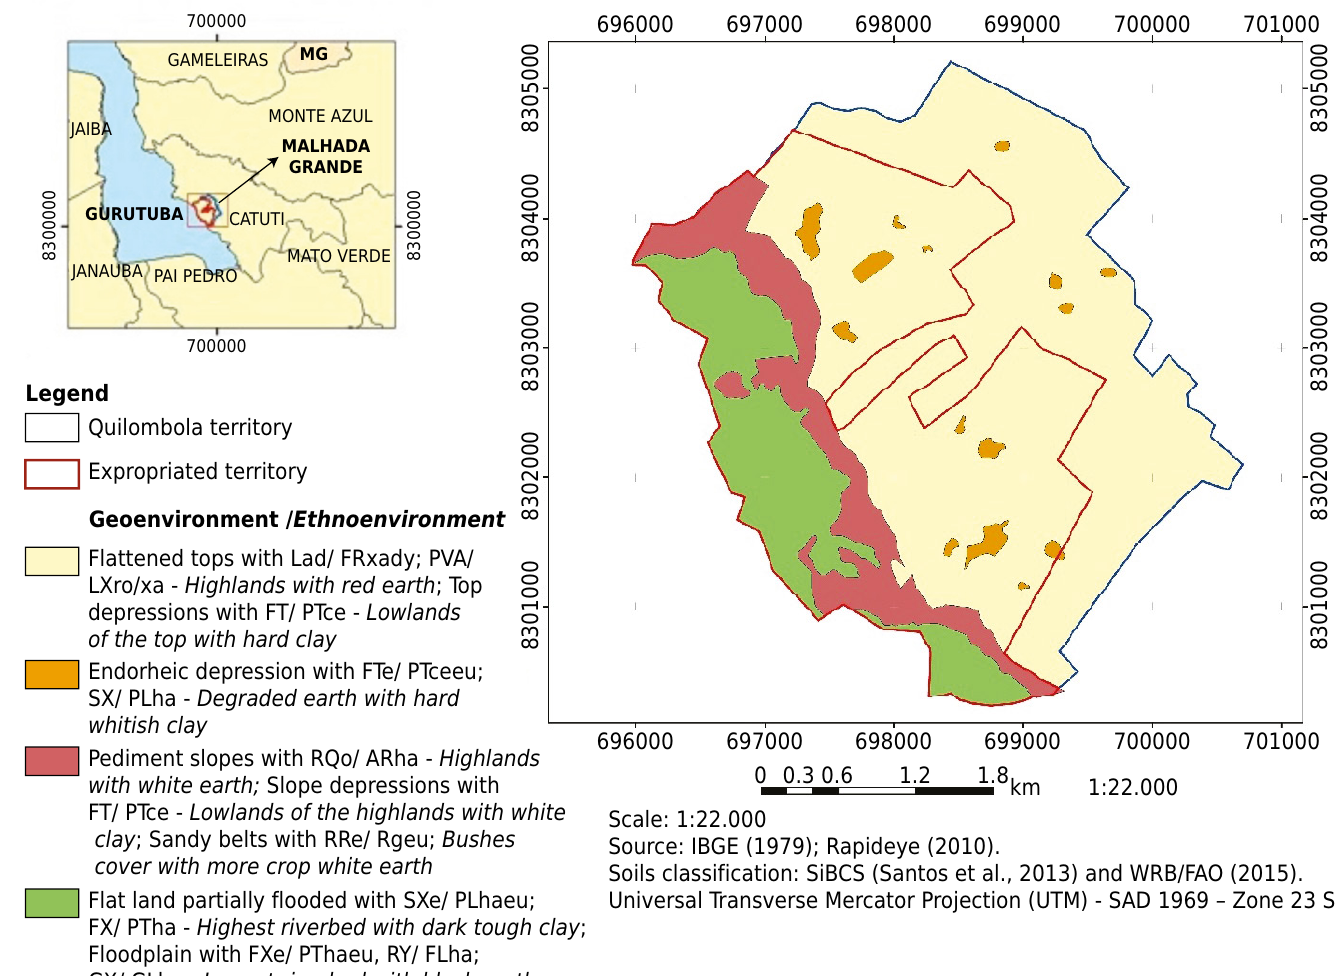
Soils classification: SiBCS (Santos et al., 2013) and WRB/FAO (2015). Universal Transverse Mercator Projection (UTM) - SAD 1969 – Zone 23